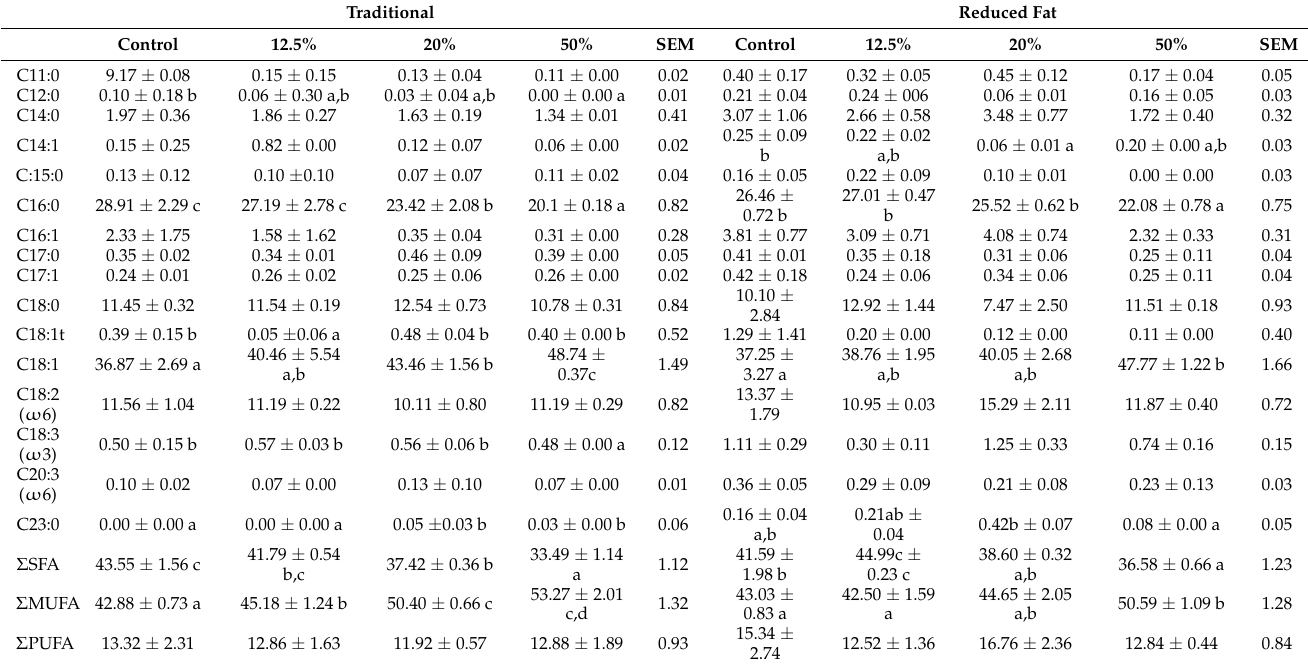
Table 4. Mean values, standard deviation, and standard error of the mean (SEM) of fatty acid compo- sition for the traditional and reduced fat “Chorizo Zamorano” formulations at the end of ripening. Traditional Reduced Fat